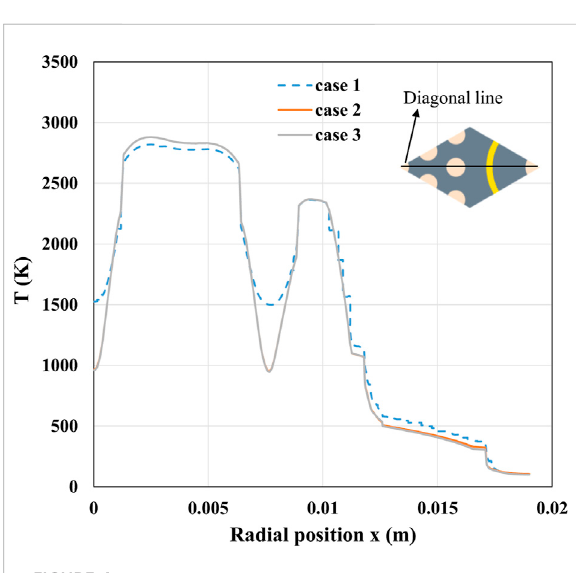
FIGURE 4 Temperature distribution on diagonal line at the half-length of the